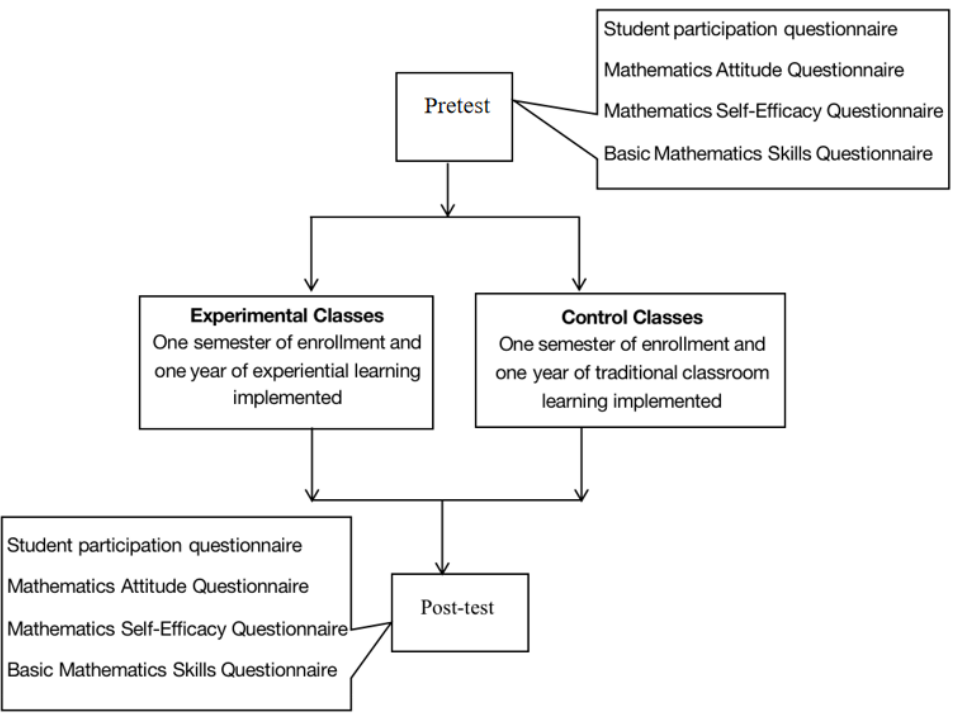
Figure 3. SEM model ‐ based experimental research pathway diagram. Figure 3. SEM model-based experimental research pathway